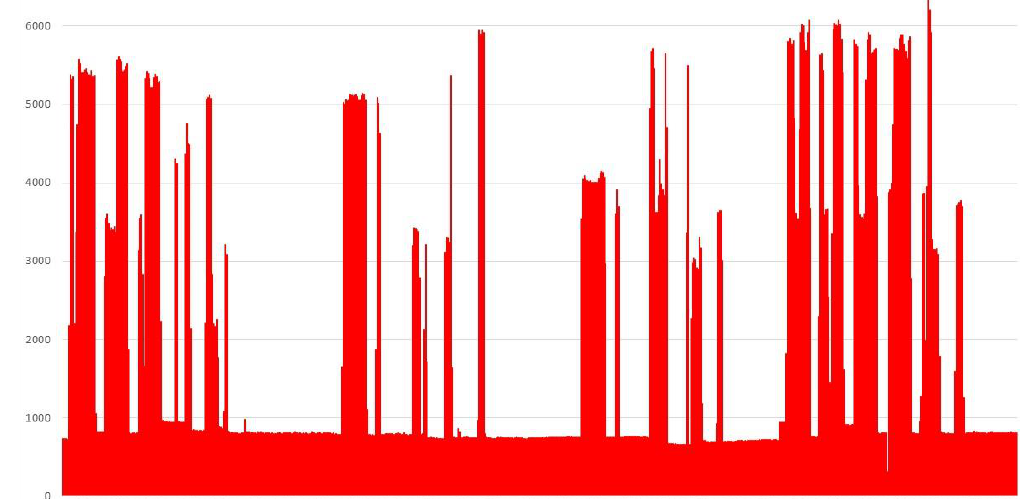
Figure 5. Average energy consumption per student in three classrooms, through the 3-month experiment, with y labelling the associated token; x is the student in a population of 1000.